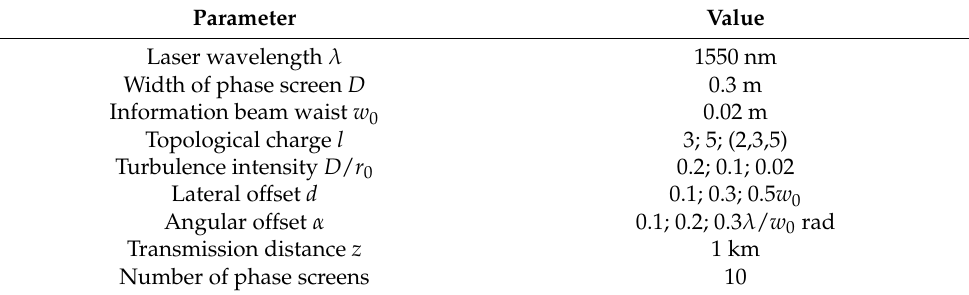
Table 1. Parameter of simulation.